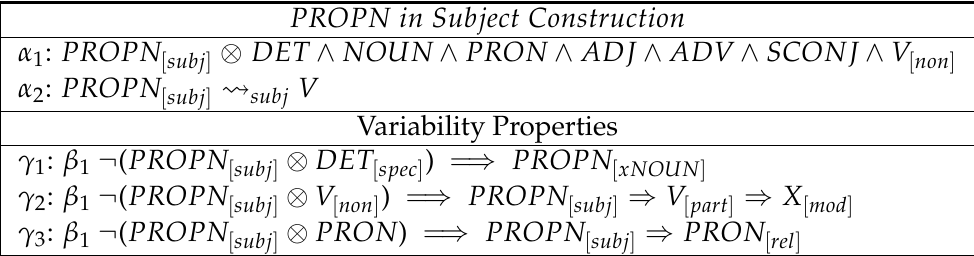
Table A4. Spanish properties of PROPN in subject construction.